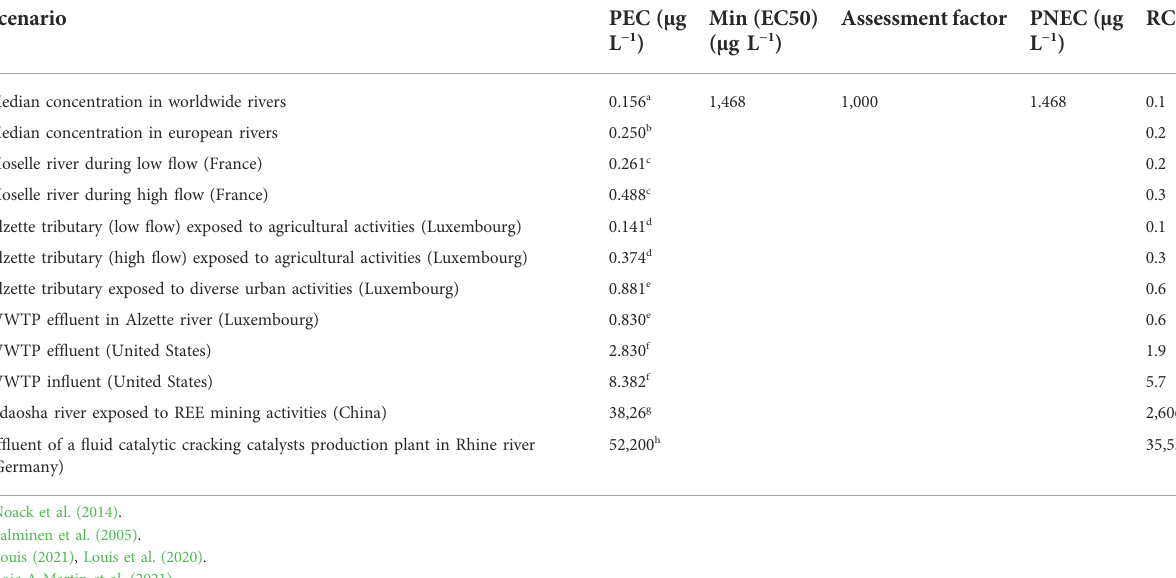
TABLE 4 Environmental risk assessment of REE under different environmental scenarios. PEC, predicted environmental concentration; Min (EC50), minimum EC50 value obtained between algal, crustacean and fi sh tests; PNEC, predicted no effect concentration = Min (EC50)/assessment factor; RCR, risk characterisation ratio = PEC/PNEC. If RCR < 1, the risk is controlled; if RCR > 1, the risk is not controlled.